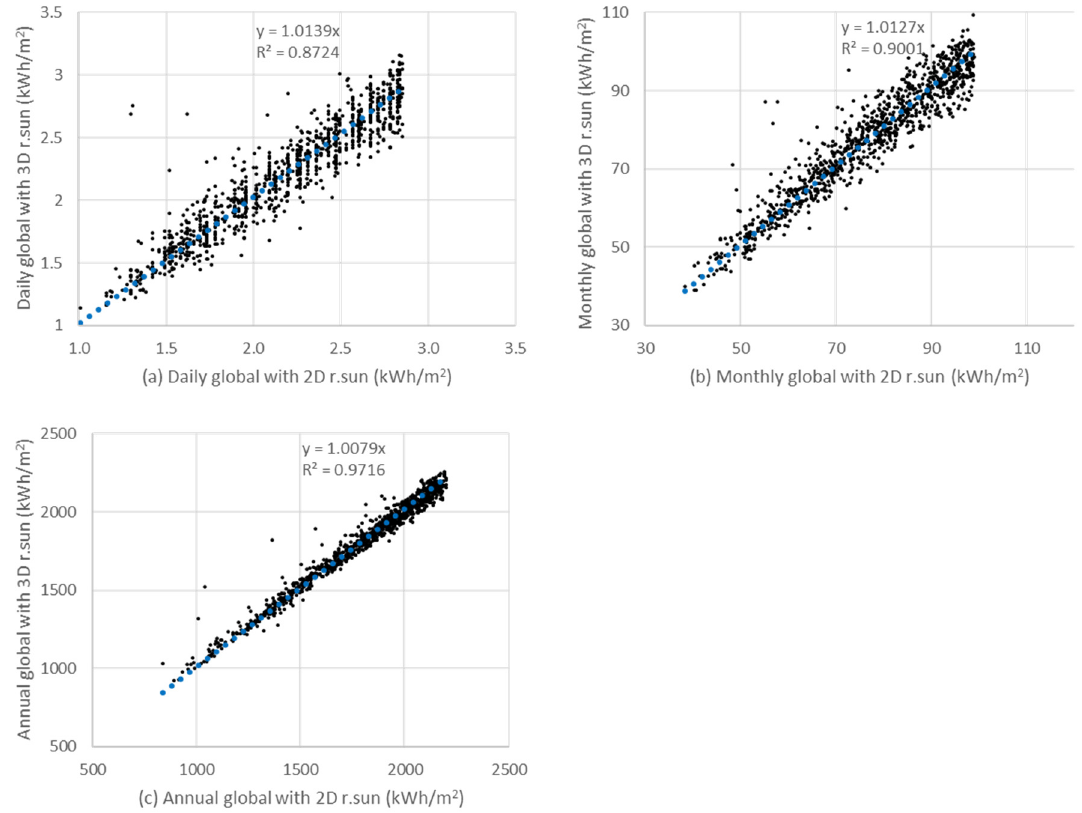
Figure 4. Comparison of global solar irradiation estimates between the r.sun 3D extension and the original r.sun (2D) for different durations. ( a ) Daily (Day 1) global; ( b ) month (Days 1–31) global; ( c ) annual global (Days 1–365).